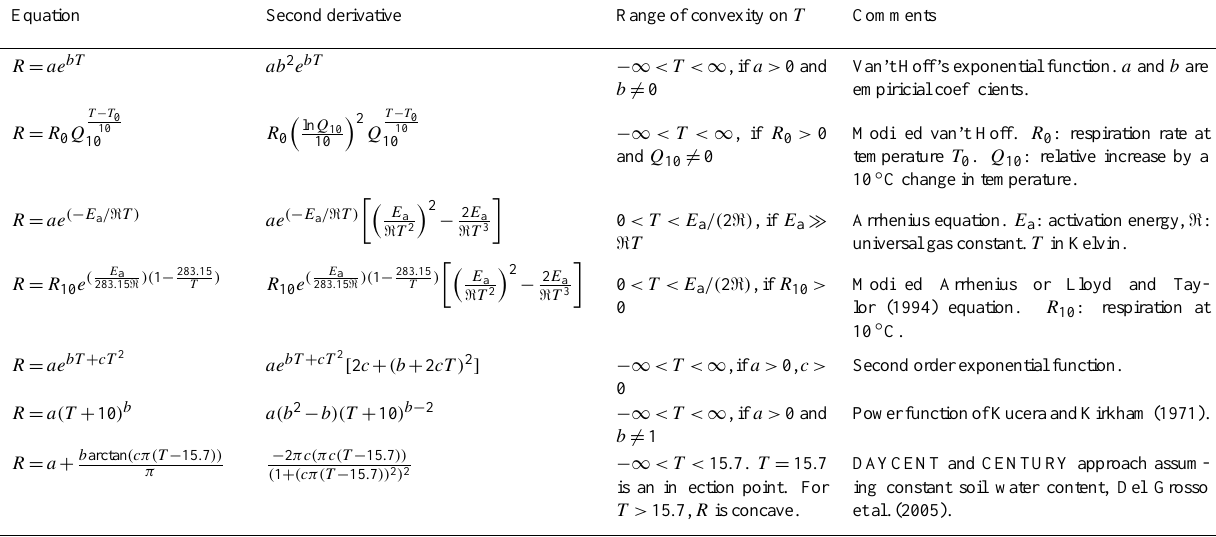
Table 1. Empirical equations commonly used to describe the relationship between temperature T and soil respiration R , with their sec- ond derivatives and range of convexity. a , b , and c represent empirical coefficients. Equations extracted from Luo and Zhou (2006) and Del Grosso et al. (2005). Equation Second derivative Range of convexity on T